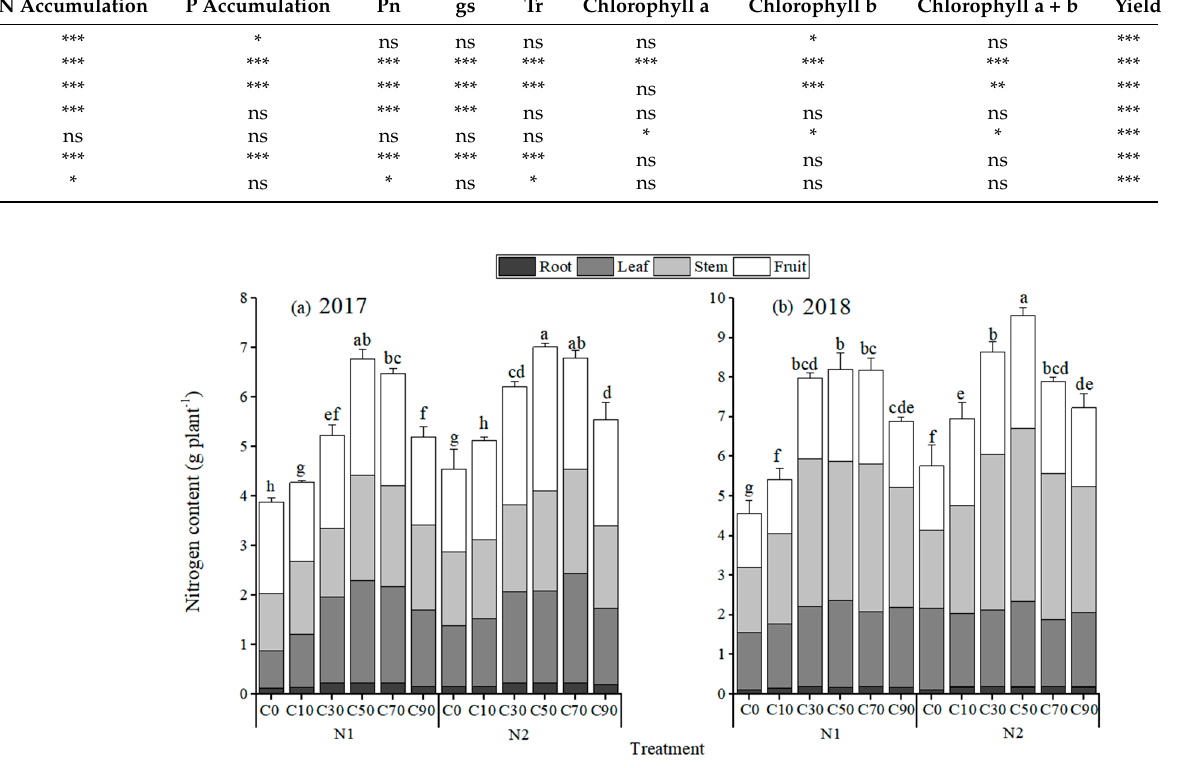
Figure 1. The effect of biochar on the N uptake of tomato plants under low (N1) and normal (N2) nitrogen fertilization in 2017 ( a ) and 2018 ( b ). Different lowercase letters denote significant differences among treatment means at the 0.05 level by Duncan’s MRT method.